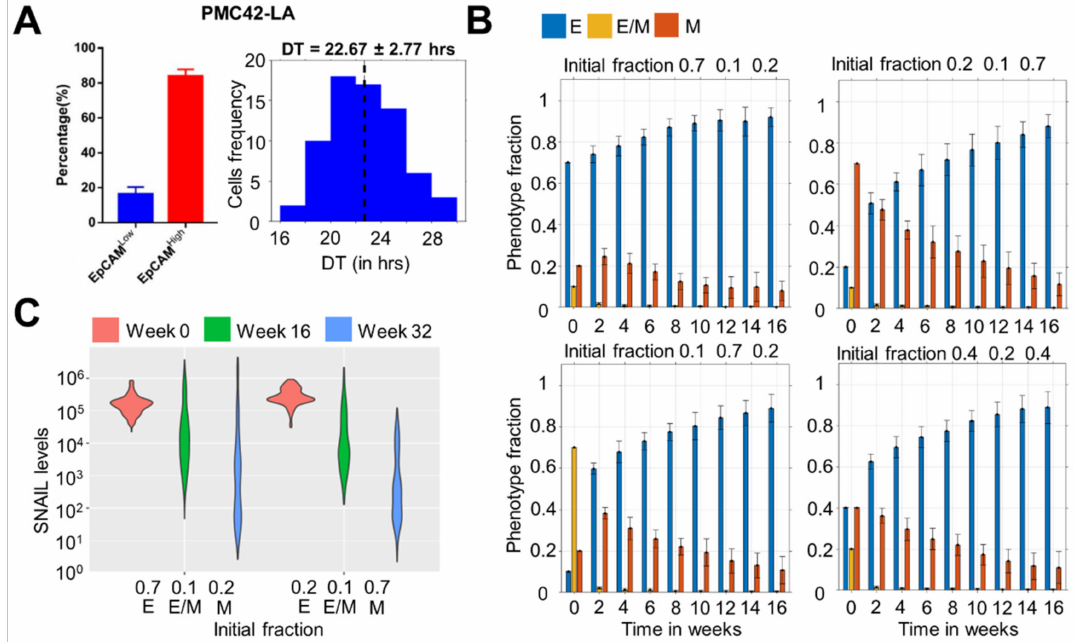
Figure 2. Dominance of the epithelial (EpCAM high ) phenotype in the population over time for multi- ple initial distributions. ( A ) Phenotypic distribution of EpCAM high and EpCAM low subpopulations in PMC42-LA cells (left—adapted from Bhatia et al. J Clin Med [20]), and their observed doubling time distribution (right). ( B ) Changes in phenotypic fraction over time starting with different fractions of E, E/M, and M cells in the population. ( C ) Change in the distribution range of SNAIL levels over 32 weeks for two different initial conditions. Average doubling time (DT) of each phenotype is set to 20 h and scaling factors η 1 and η 2 to 0.2 and 0.1. The initial population size was 200 cells. Mean and standard deviation calculated from 16 independent